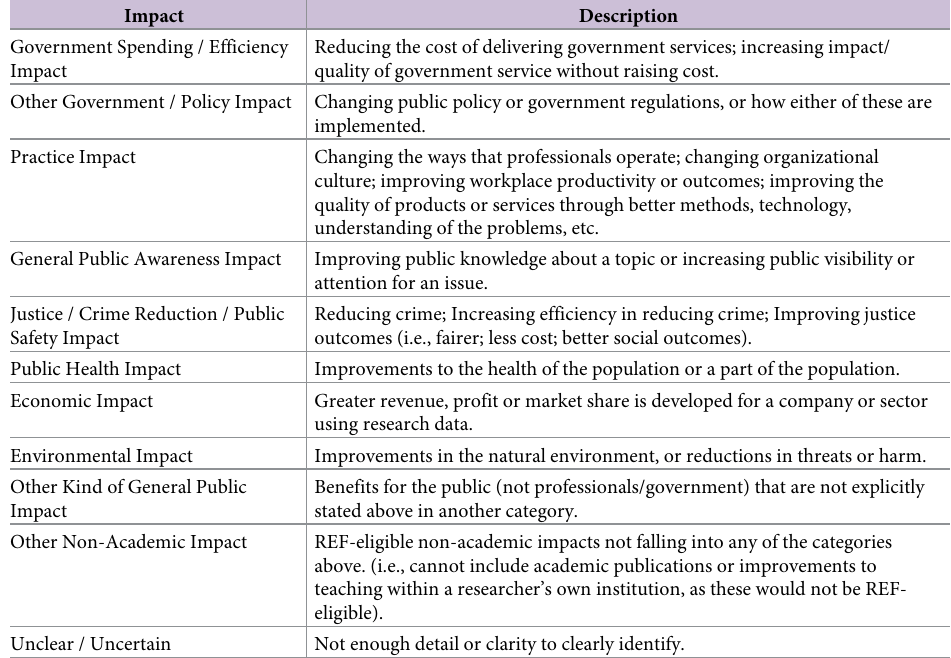
Table 3. Identified types of